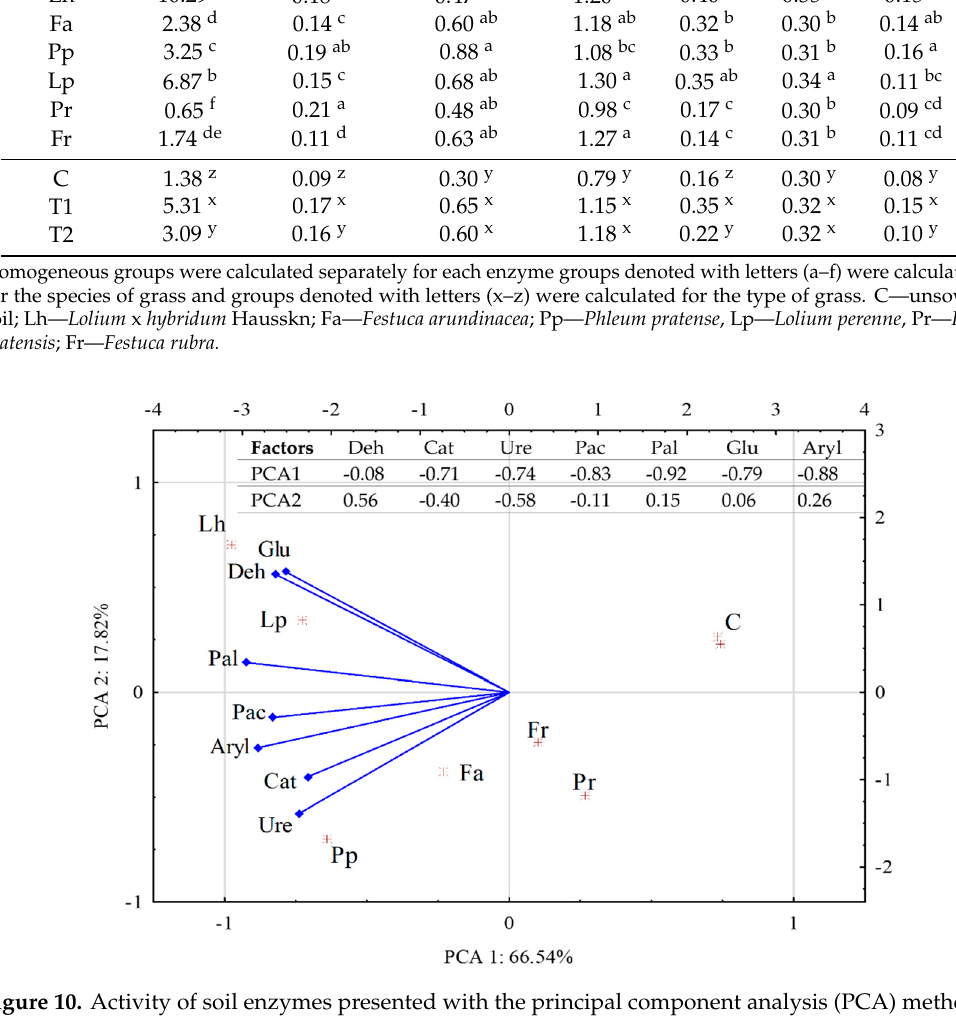
Figure 10. Activity of soil enzymes presented with the principal component analysis (PCA) method.